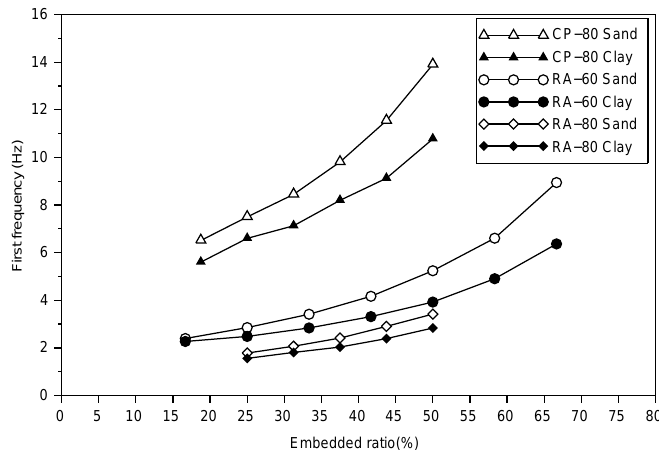
Figure 7. Variation of first frequency with embedded ratio in sand and clayey soil